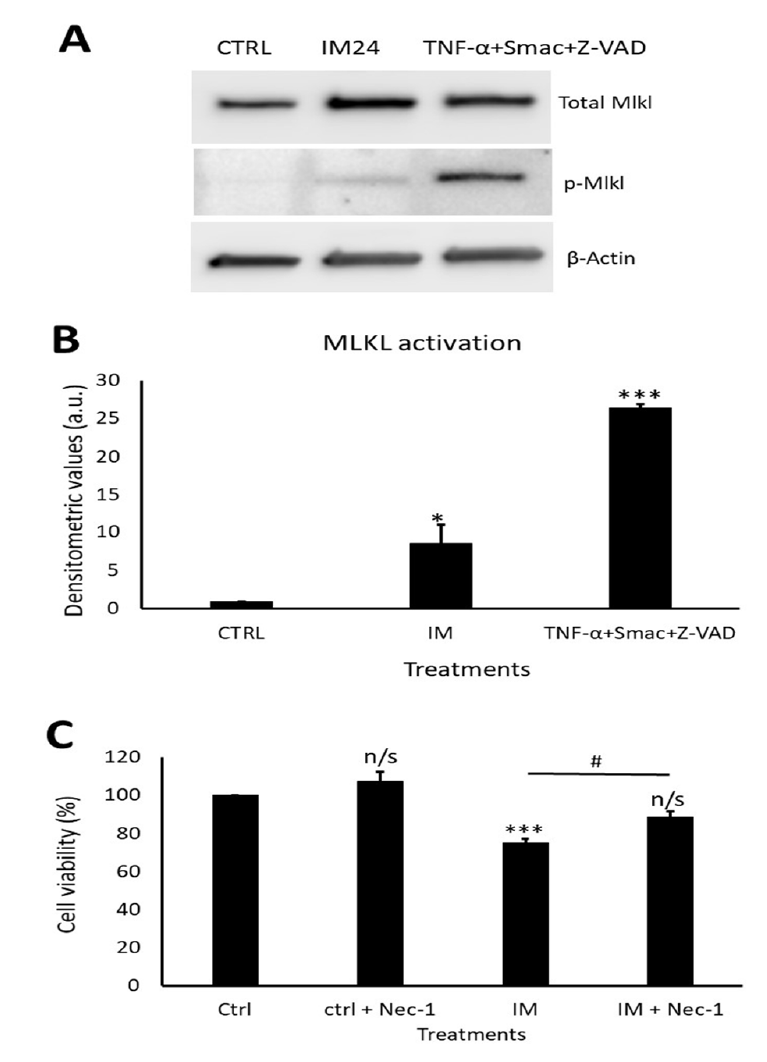
Figure 7. IM induces necroptosis cell death and is rescued by RIP1 inhibition. ( A ) Western blot representative image showing expression of total MLKL and p-MLKL after IM 24 h treatment and positive control. ( B ) Densitometric values show MLKL activation after IM treatment and in the positive control, n = 3. ( C ) Cell viability analysis of necrostatin (nec-1) inhibition with control cells treated with nec-1, IM alone, and IM co-treated with nec-1. Data are mean ± SEM, n = 4; * p < 0.05, *** p < 0.001, and n/s = not significant vs. control; # p < 0.05 vs. IM 24 h treatment.